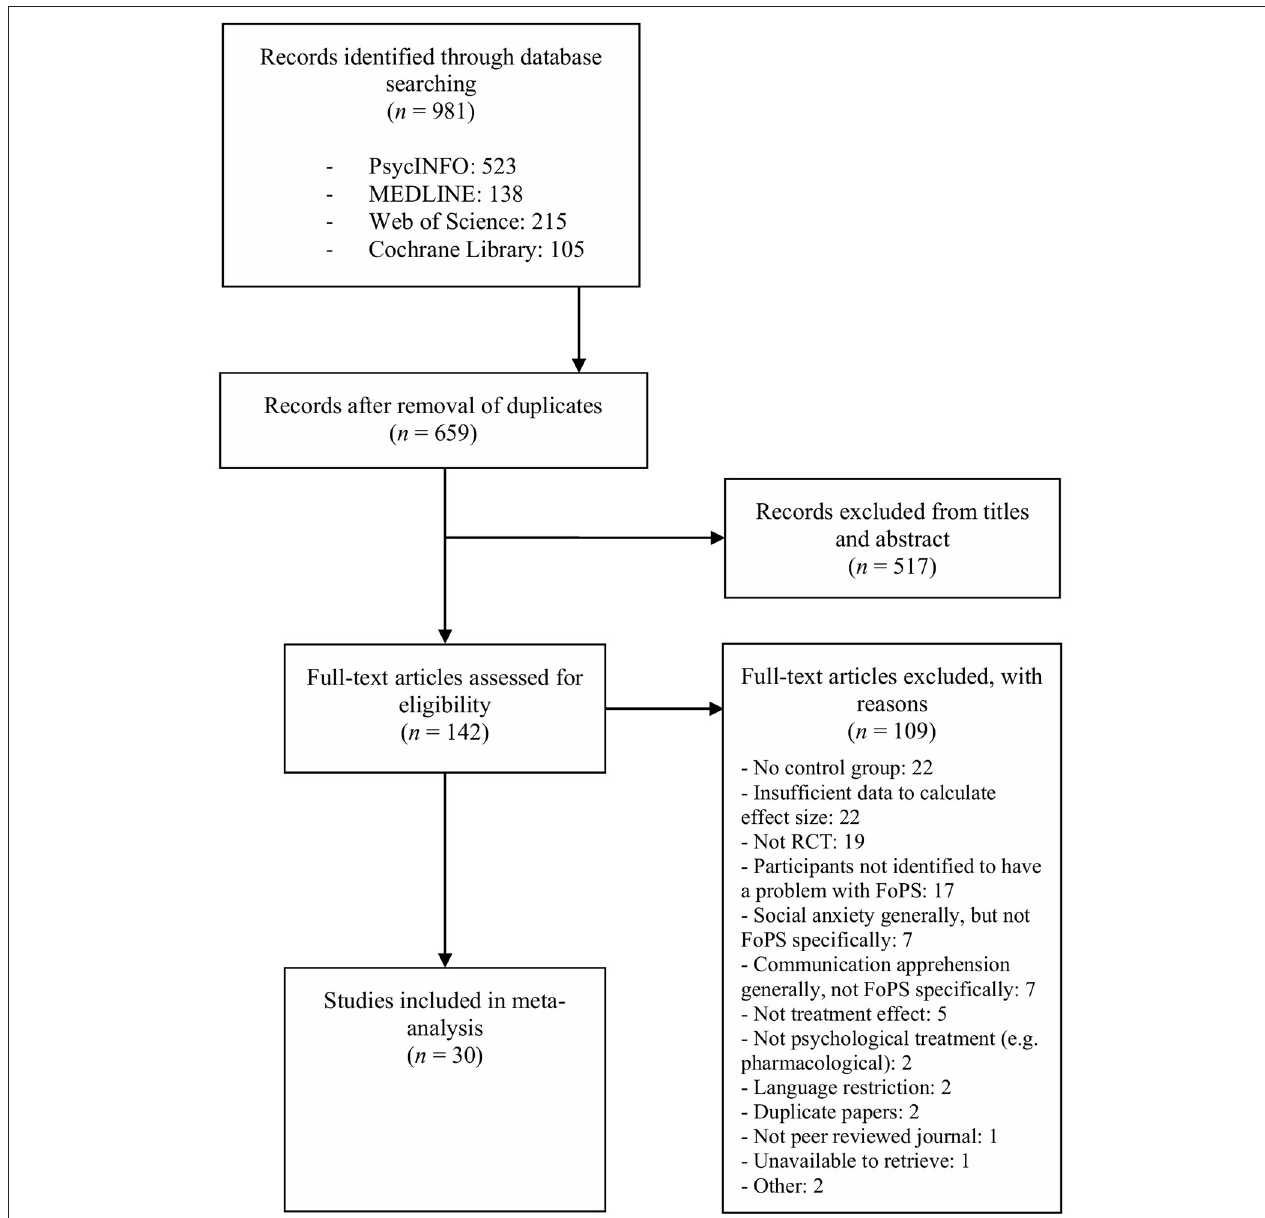
FIGURE 1 | PRISMA flow diagram of the study selection